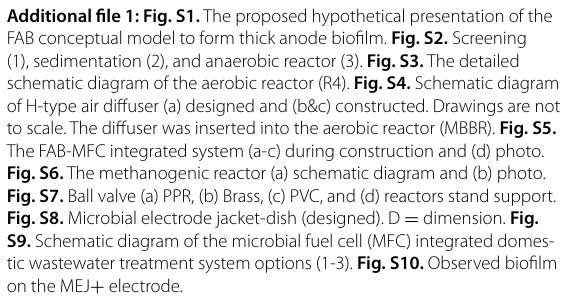
S9. Schematic diagram of the microbial fuel cell (MFC) integrated